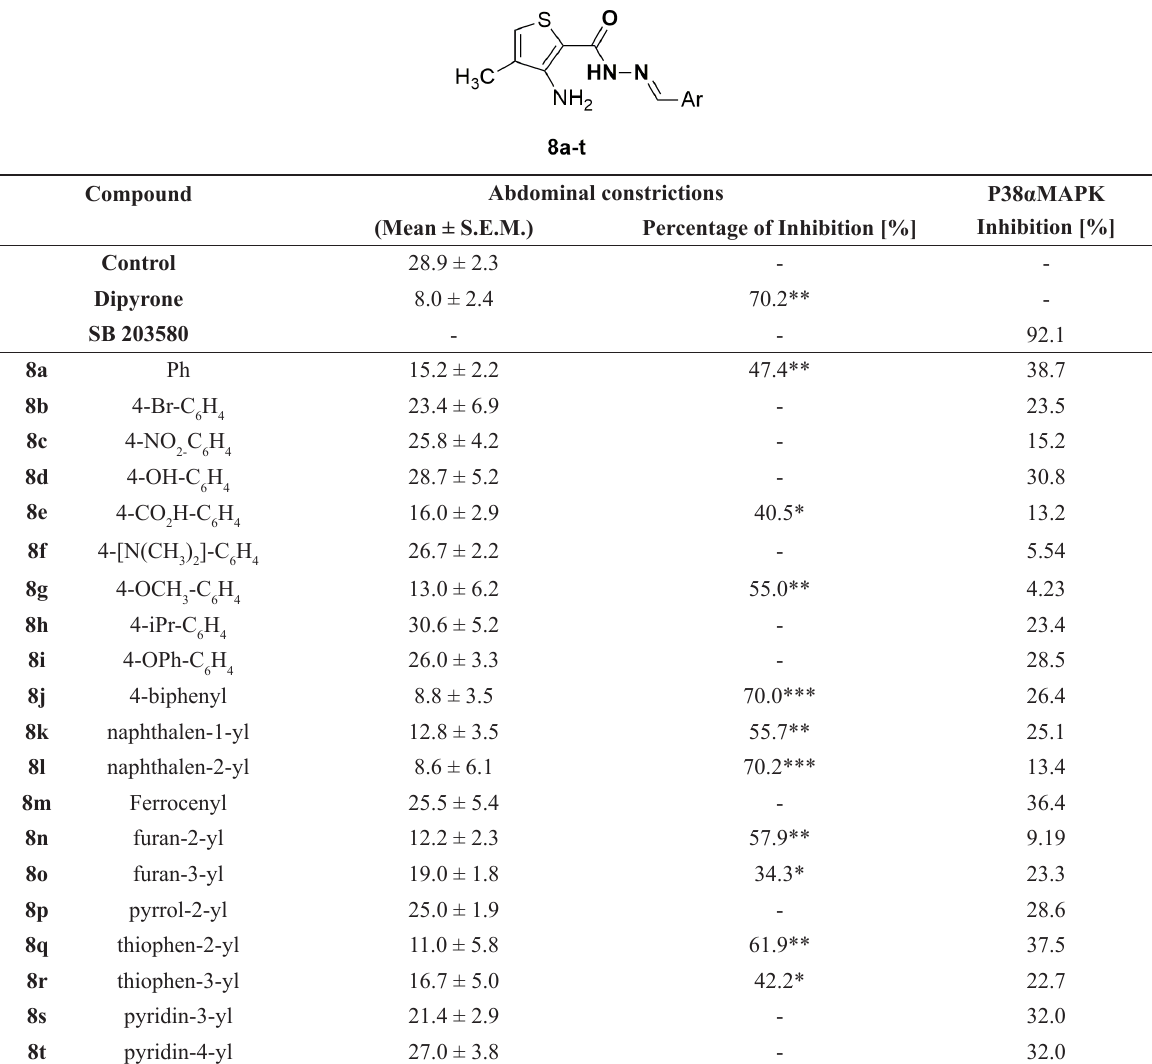
Effect of the target compounds (8a-t) and dipyrone (100 µmol/kg; p.o.) on the 0.6% acetic acid-induced abdominal constriction model in mice (period of 25 min), and, in the last column, percentage of inhibition of p38α MAPK enzymatic activity for the compounds (8a-t) and positive standard SB-203580 (10µM) in the nonradioactive immunosorbent assay.